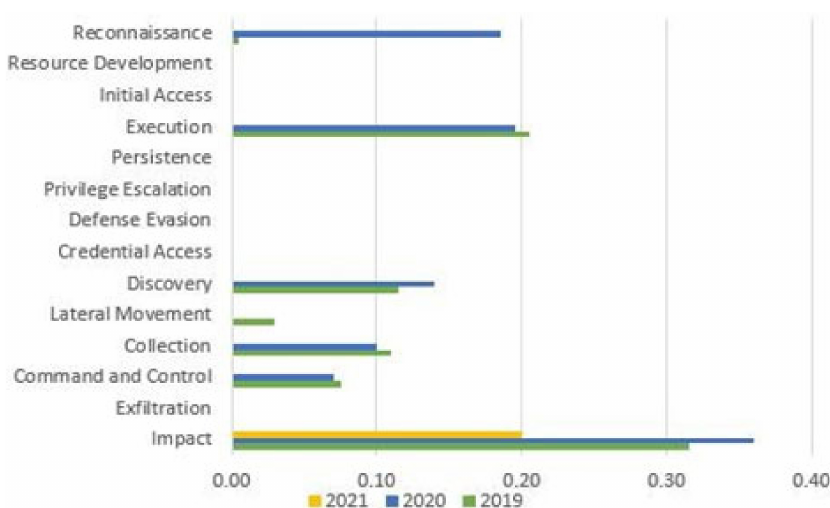
Figure 7. Techniques MITRE identified in works selected in this study.